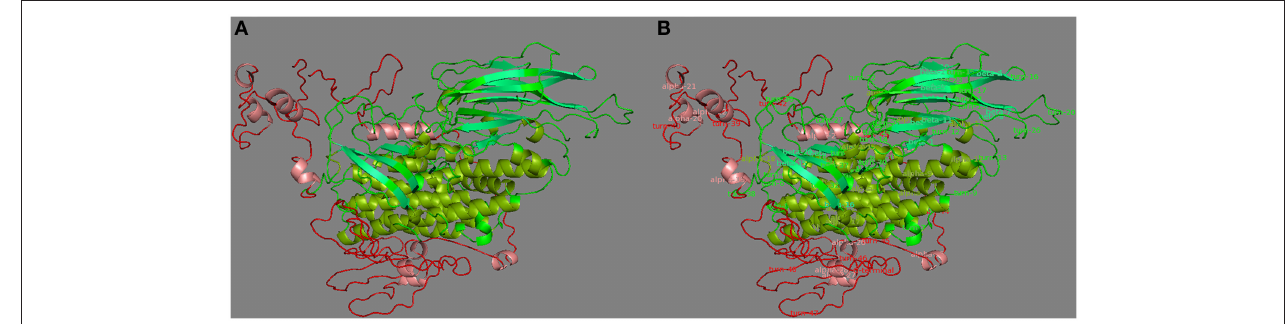
FIGURE 2 | (A) Three dimensional protein model of Cry1Ac-Vip3Aa fusion protein, predicted by I-TASSER. Where, green and red represent Cry1Ac and Vip3A domains, respectively. (B) Secondary structure labeled 3D Cry1Ac-Vip3Aa fusion protein model. Where, the α -helices and β -sheets of Cry1Ac are represented by split-pea and lime-green colors, respectively. Whereas, the α -helices of Vip3Aa are represented by salmon